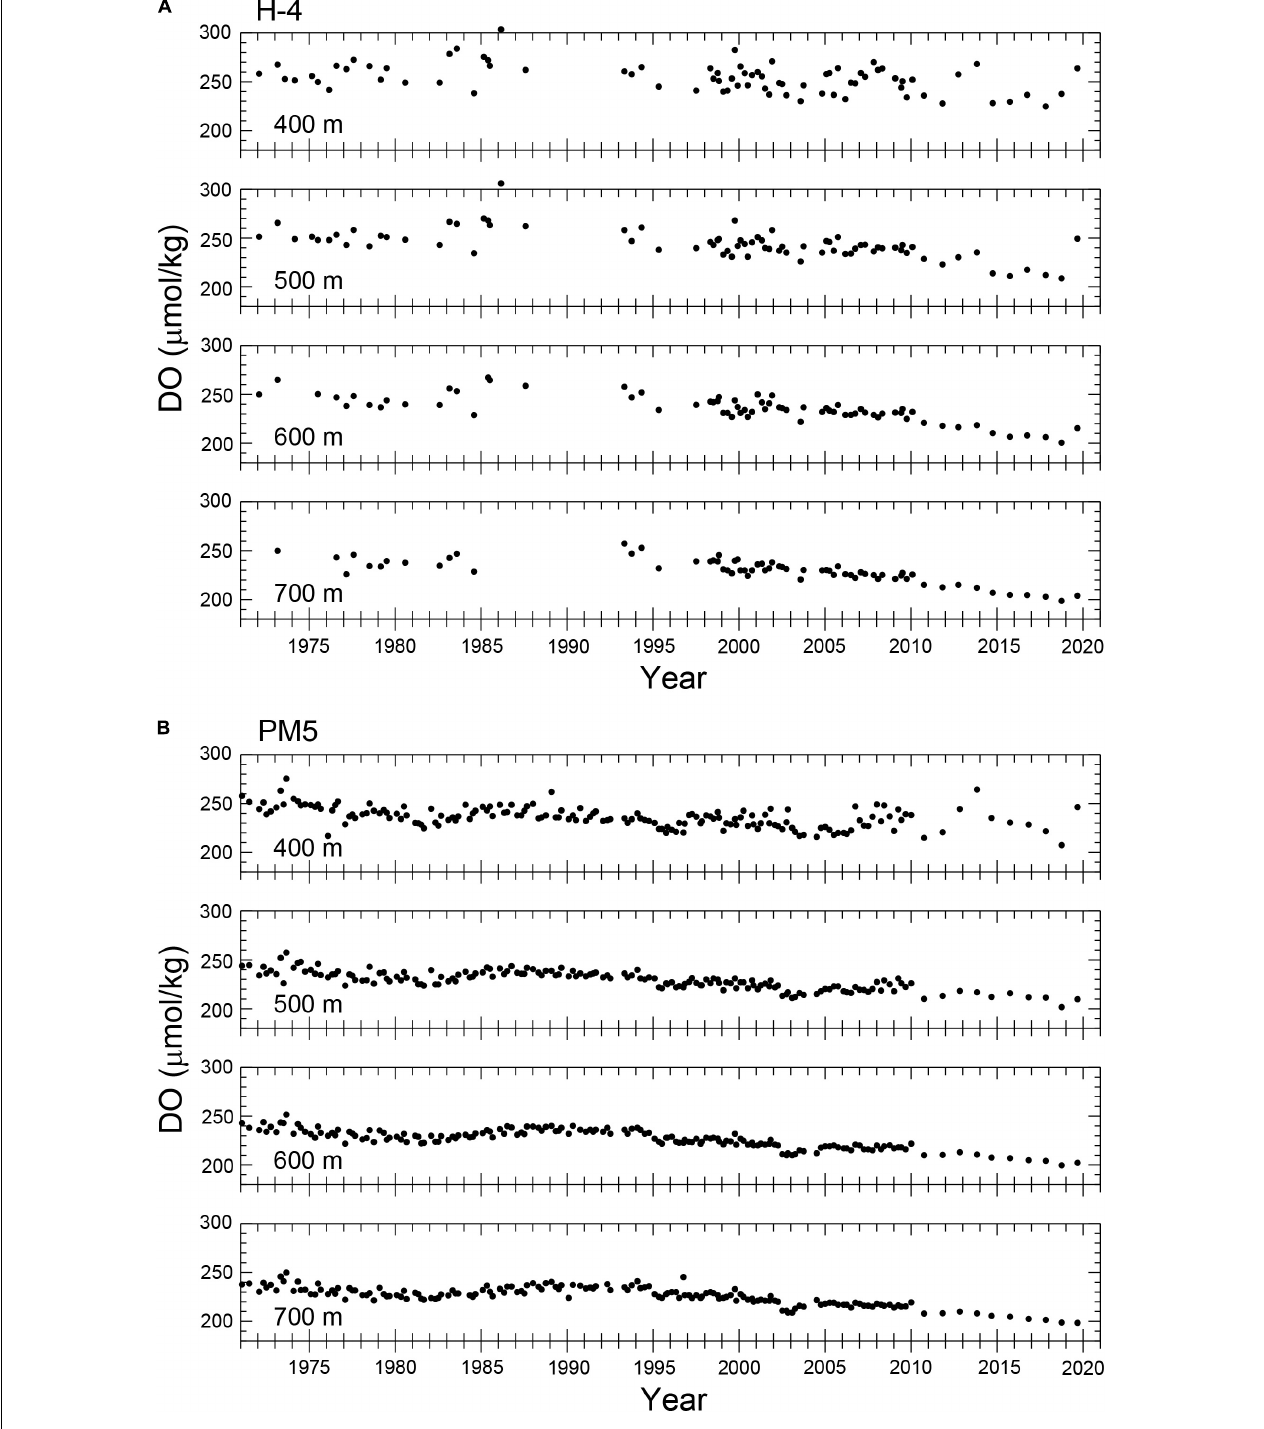
FIGURE 12 | DO time series at 400, 500, 600, and 700 m at (A) Stas. H-4 and (B) PM5.